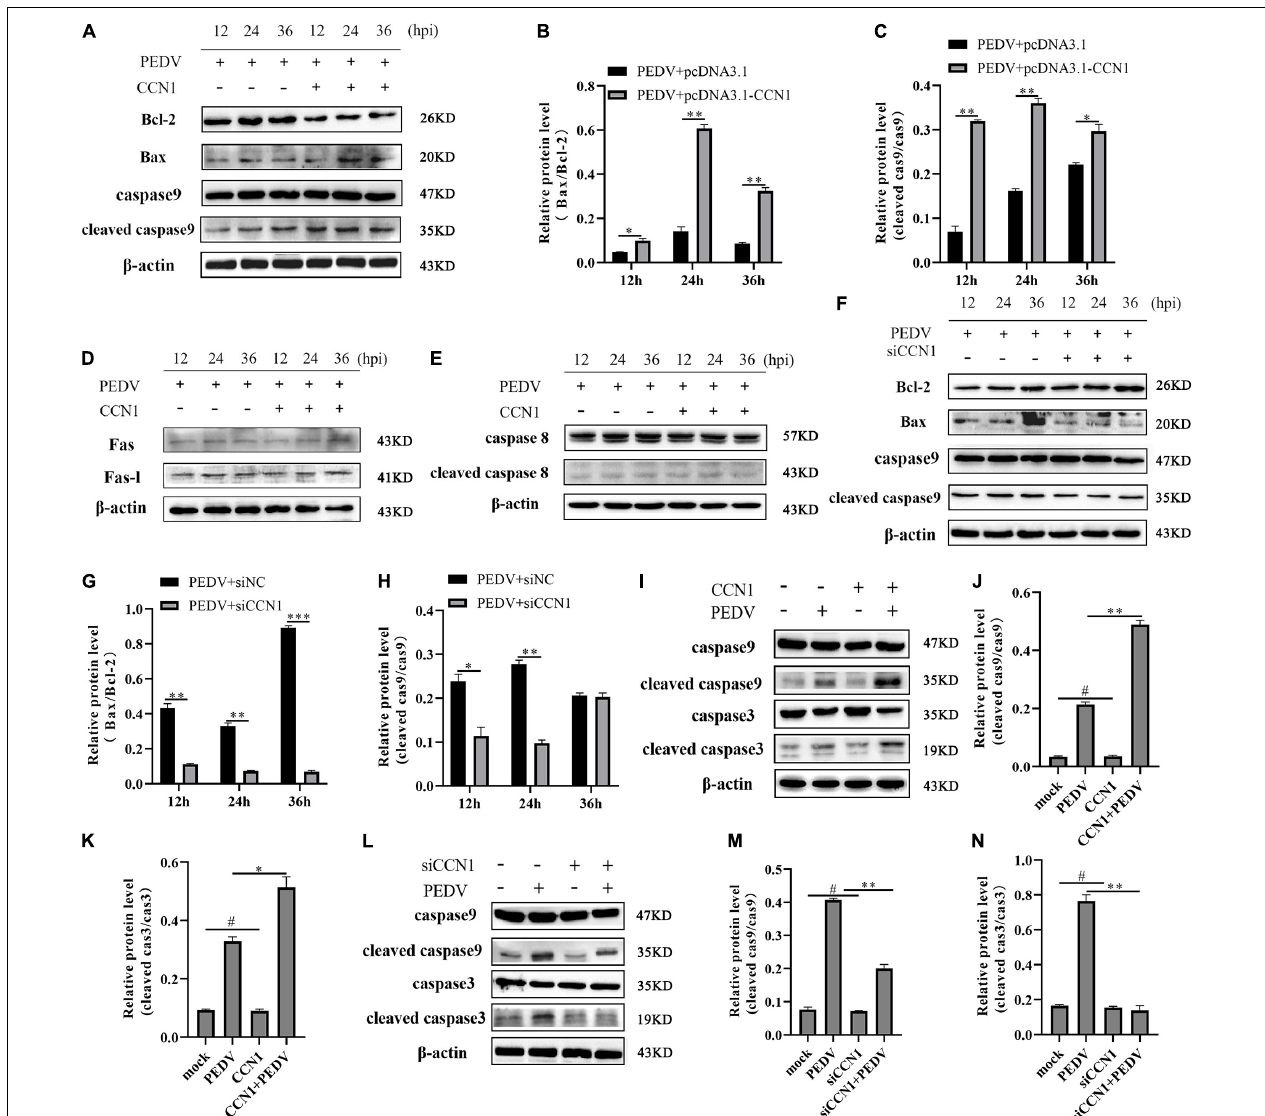
FIGURE 8 | The mitochondrial pathway was involved CCN1 induced apoptosis. (A–C) Marc-145 cells were transfected with pcDNA3.1-CCN1-his or pcDNA3.1-his vector for 36 h and infected with the PEDV. Cells were harvested at the indicated time, Western blot was used to assess the expression of the Bcl-2, Bax, caspase 9, and cleaved caspase 9 (A) , densitometric analysis of Bax relative to Bcl-2, and cleaved caspase 9 relative to caspase 9 using ImageJ (B,C) . Western blot was used to elevate the level of the Fas-L, Fas, caspase 8, and cleaved caspase 8 (D,E) . (F–H) Marc-145 cells were transfected with siNC or siCCN1 for 48 h and infected with the PEDV. Cells were harvested at the indicated time, Western blot was used to assess the expression of the Bcl-2, Bax, caspase 9, and cleaved caspase 9 (F) , densitometric analysis of Bax relative to Bcl-2, and cleaved caspase 9 relative to caspase 9 using ImageJ (G,H) . (I–K) Marc-145 cells were transfected with pcDNA3.1-CCN1-his or pcDNA3.1-his vector for 36 h and infected with the PEDV. Cells were harvested at 24 h after PEDV infection, Western blot was used to assess the expression of the caspase 9, cleaved caspase 9, caspase 3, and cleaved caspase 3 (I) , densitometric analysis of cleaved caspase 9 relative to caspase 9, and cleaved caspase 3 relative to caspase 3 using ImageJ (J,K) . (L–N) Marc-145 cells were transfected with siNC or siCCN1 for 48 h and infected with the PEDV. Cells were harvested at 24 h after PEDV infection, and Western blot was used to assess the expression of the caspase 9, cleaved caspase 9, caspase 3, and cleaved caspase 3 (L) , densitometric analysis of cleaved caspase 9 relative to caspase 9, and cleaved caspase 3 relative to caspase 3 using ImageJ. (M,N) The data were performed from three independent experiments. The differences were evaluated using Student’s t -test, and significance differences were denoted by ∗ p < 0.05, ∗∗ p < 0.01, and ∗∗∗ p <